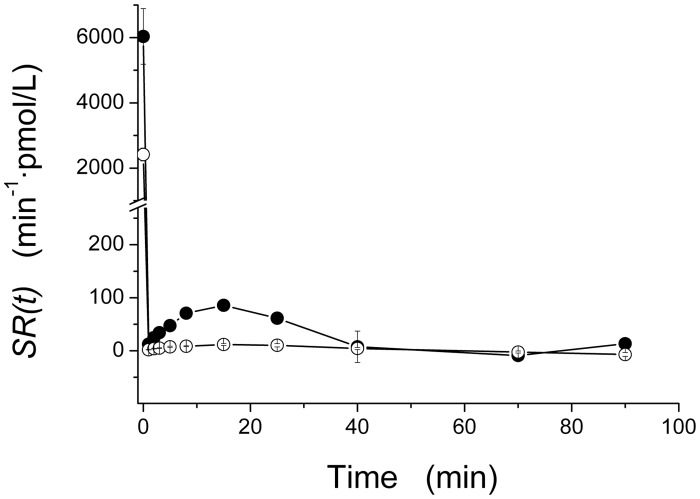
Time course of above steady-state insulin secretion rate, SR(t), during 90-min IVGTT in our ZFR group (n = 7, closed circles) and ZLR group (n = 7, open circles).Values are mean ± SE.